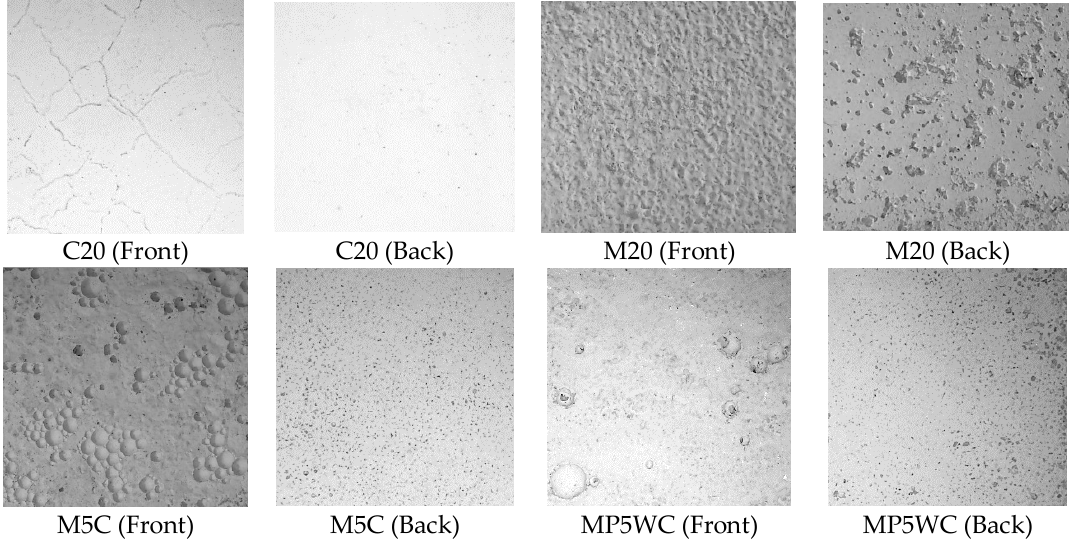
Figure 15. Front and back surfaces of selected specimens (25-mm